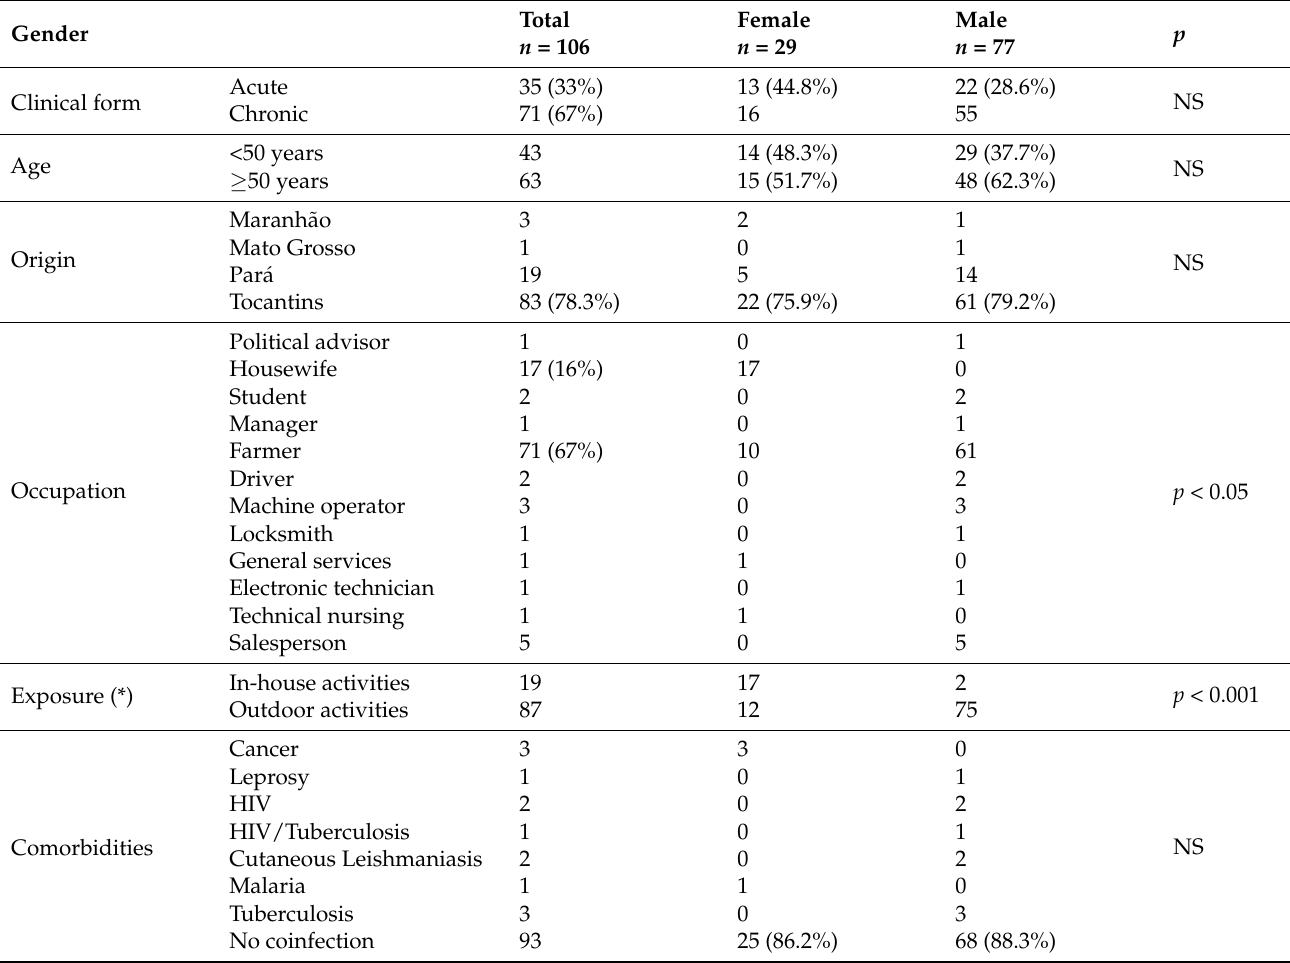
Table 1. Demographics, occupation, and comorbidities of patients with paracoccidioidomycosis in Aragua í na Tocantins sorted by